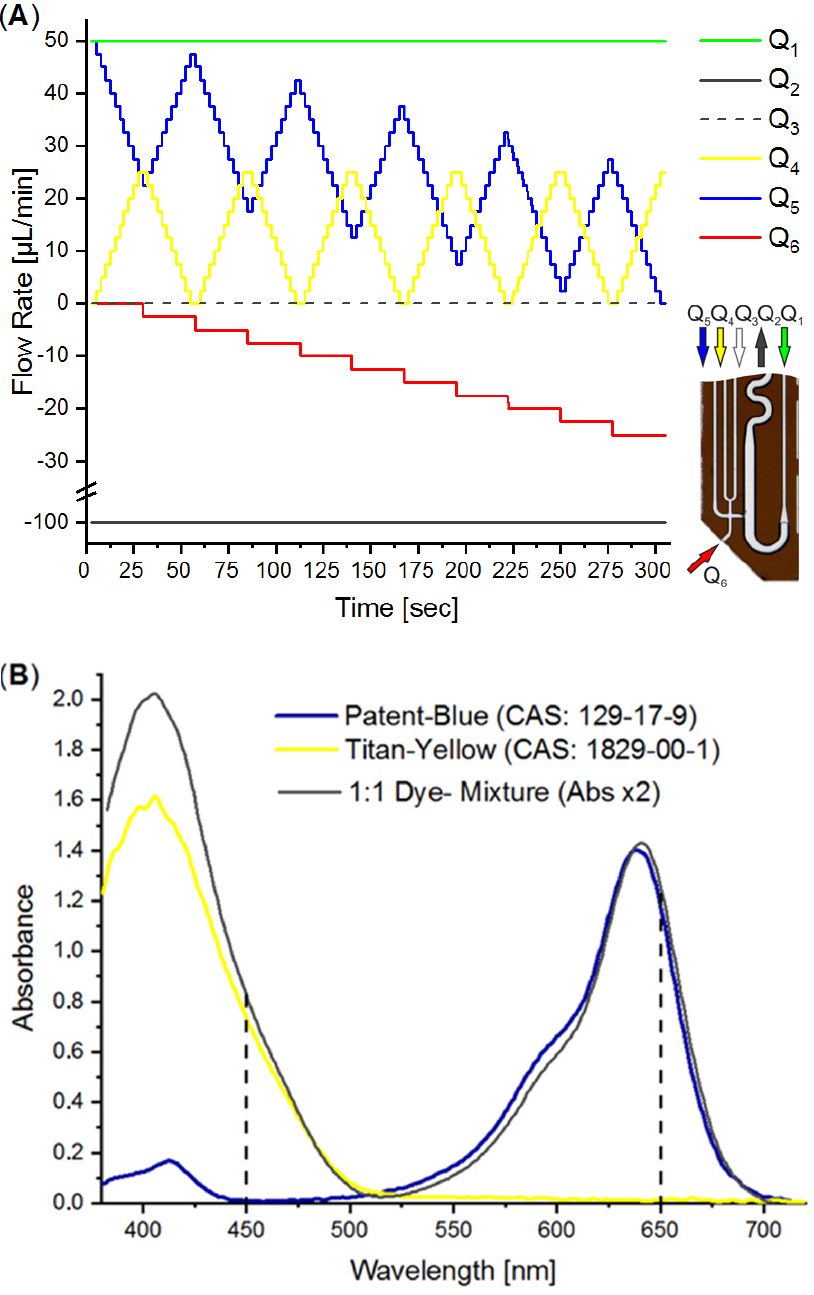
Figure 7. ( A ) Flow rate program for the generation of droplet sequence covering a 2D concentration space. ( B ) UV-Vis spectra of the used indicator dye solutions and mixture. Flow rate Q = dV